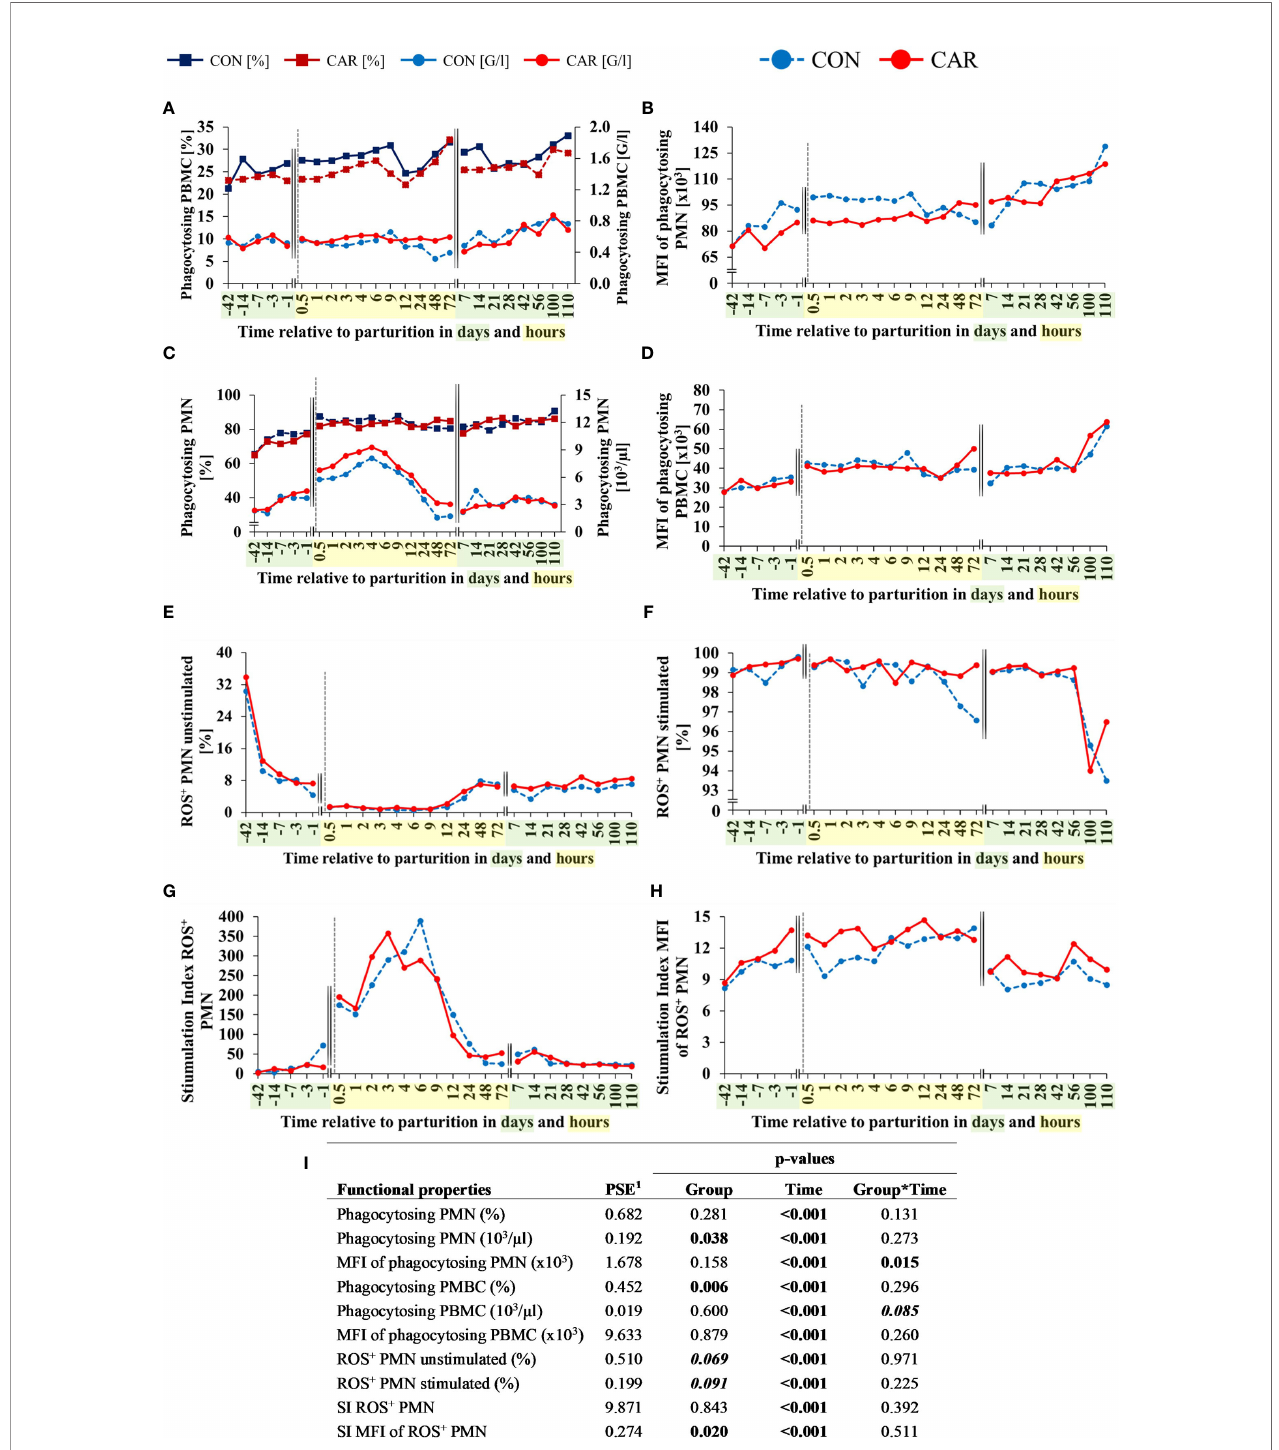
FIGURE 5 | Functional properties of leukocytes of dairy cows fed a diet supplemented with (CAR) or without (CON) L-carnitine from 6 weeks before until 15 weeks after calving. (A) percentages and calculated numbers of phagocytosing polymorphonuclear leukocytes (PMN), (B) mean fl uorescence intensities (MFI) of phagocytosing PMN, (C) percentages and calculated numbers of phagocytosing peripheral blood mononuclear cells (PBMC), (D) MFI of phagocytosing PBMC, (E) percentages of unstimulated reactive oxygen species (ROS + ) producing PMN and (F) percentages of 12-O-tetradecanoylphorbol-13-acetate (TPA)-stimulated ROS + PMN were determined by fl ow cytometry. Calculated stimulation index (SI) of percentage (G) and MFI (H) of stimulated and unstimulated ROS + PMN. (I) Data statistics. Data are shown as least square means or as calculated numbers by offsetting results against to those of the absolute cell count. 1 pooled standard